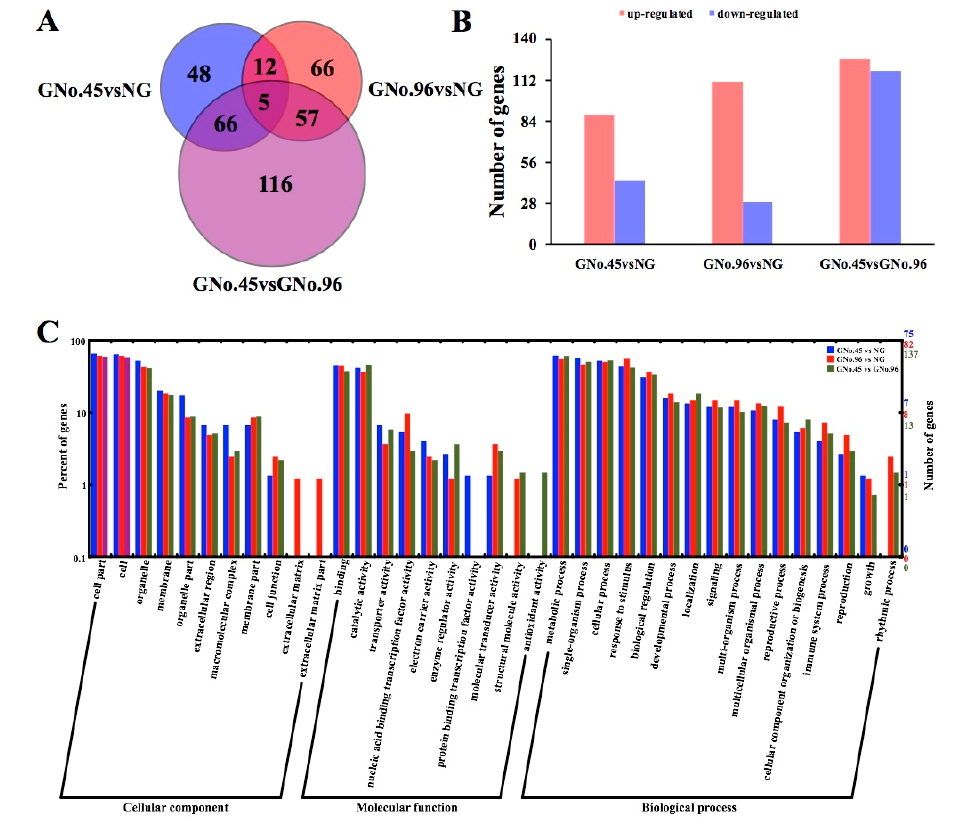
Figure 4. Number and gene ontology (GO) classification enrichment of differentially expressed genes (DEGs) among different comparisons of GNo.45 vs. NG, GNo.96 vs. NG, and GNo.45 vs. GNo.96. ( A ) Venn-diagram of significantly different DEGs. ( B ) Number of up- and down-regulated DEGs. ( C ) GO classification significant enrichment was analyzed by pairwise comparisions of GNo.45 vs. NG, GNo.96 vs. NG, and GNo.45 vs. GNo.96. ( p < 0.05). The DEGs were assigned into three classifications of the cellular components, molecular function, and biological process.